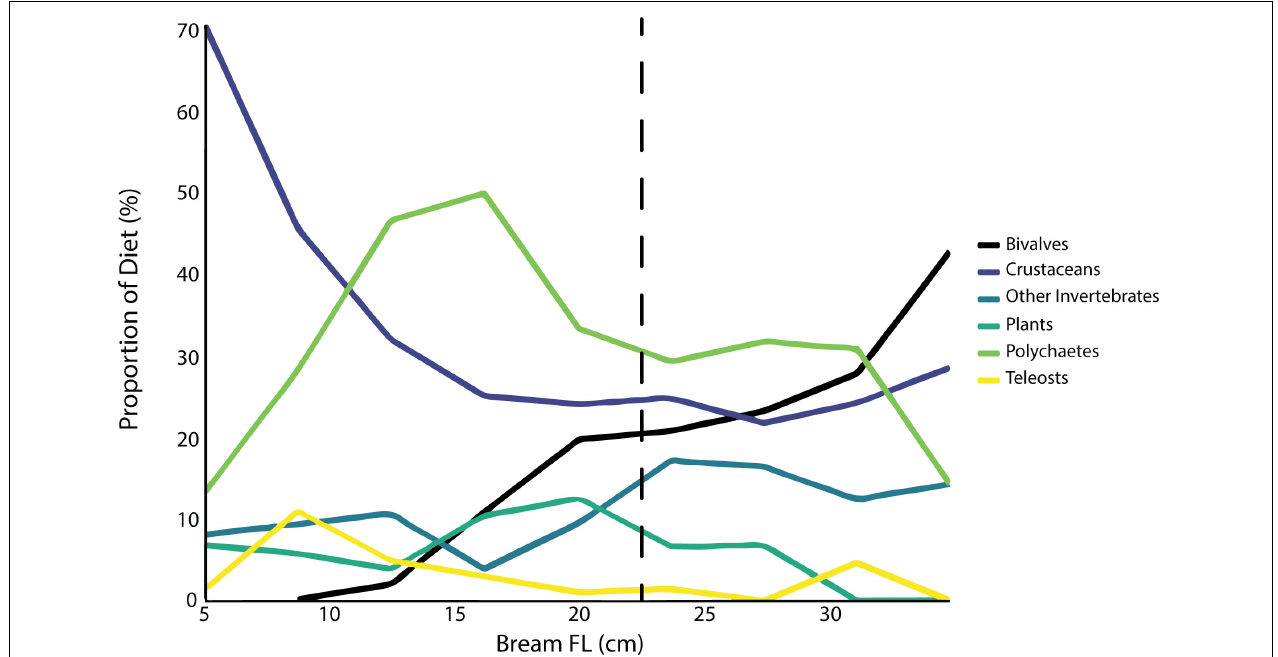
FIGURE 1 | Proportion of diet of major prey types by volume with Yellowfin Bream length. The dashed vertical line at 22 cm indicates length at maturity.